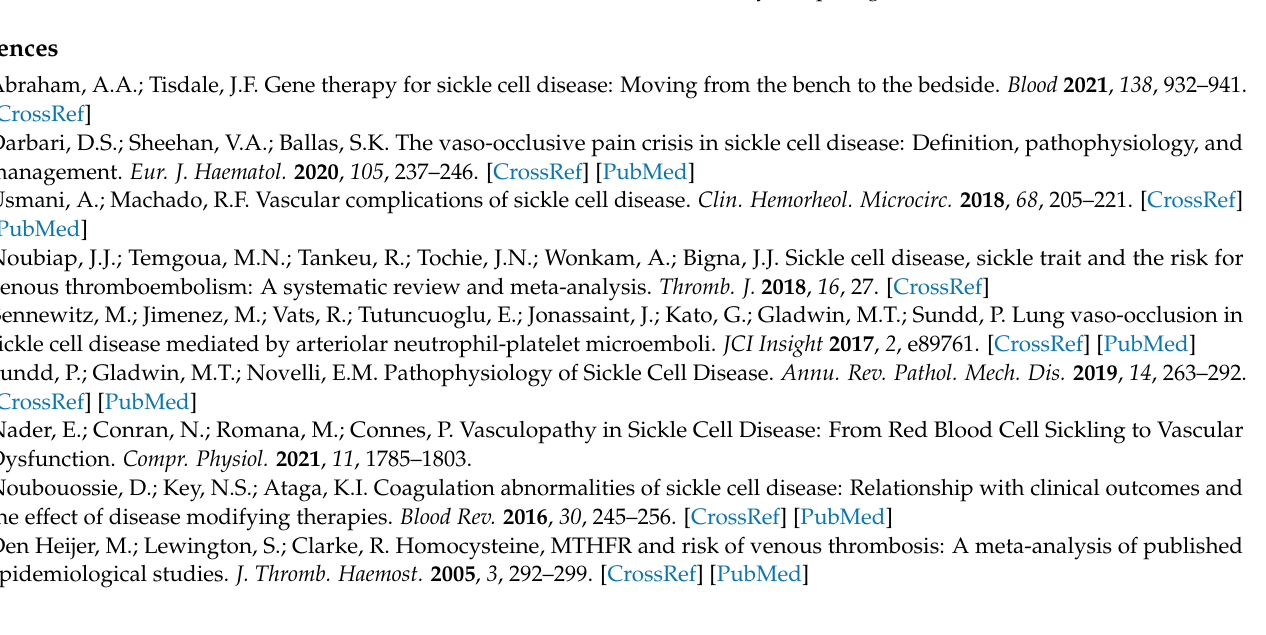
means; Figure S2: Plasma homocysteine in sickle cell disease; Figure S3A: Plasma homocysteine by vaso-occlusive crisis; Figure S3B: Plasma homocysteine by vaso-occlusive crisis; Figure S3C: Plasma homocysteine by vaso-occlusive crisis; Figure S4: Methylenetetrahydrofolate reductase 1298CC in sickle cell